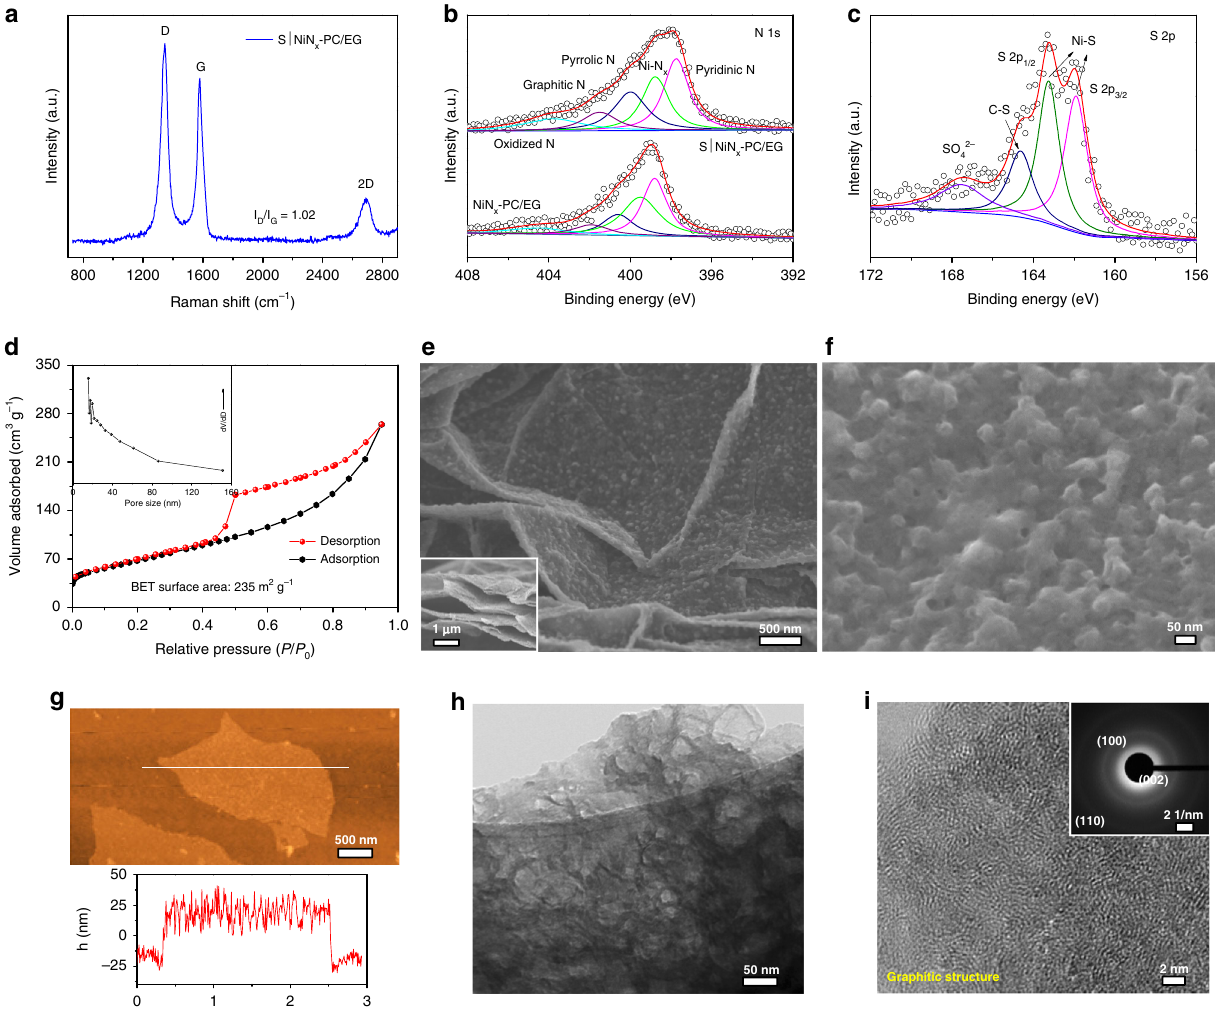
Fig. 1 Morphological and structural characterizations. a Raman spectrum, b , c High-resolution N 1s and S 2p XPS spectra, d N 2 adsorption isotherm and corresponding pore-size distributions (inset), e , f FESEM images, g AFM image, h , i TEM and HRTEM images of S|NiN x − PC/EG. Inset in i : SAED pattern of S|NiN x − PC/EG. Data for NiN x − PC/EG is also